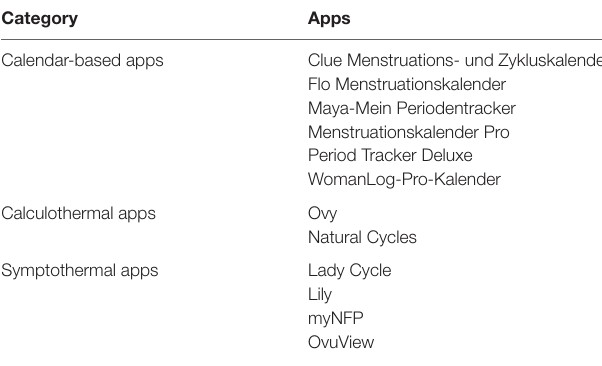
Table 1 | Cycle Apps included based on their